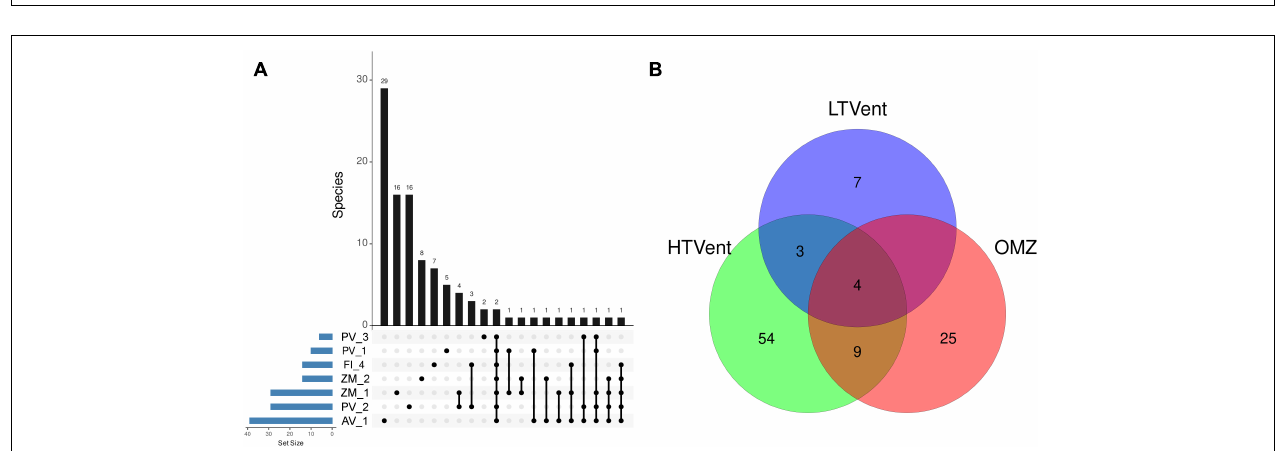
FIGURE 8 | Principal component analysis (PCA) on Hellinger-transformed abundance data showing clustering patterns in fungal ASVs from deep-sea low- and high-temperature hydrothermal vents, and an oxygen minimum zone.